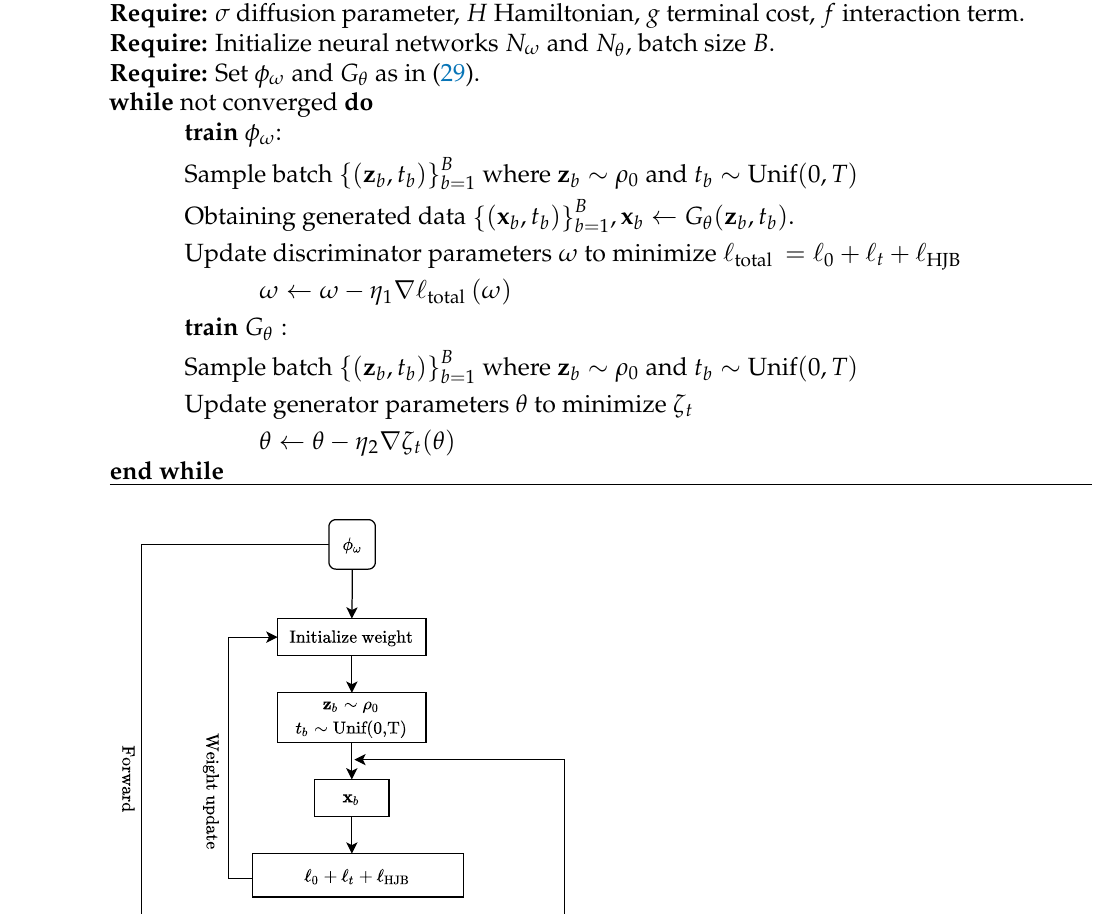
Algorithm 1 GAN-based algorithm for complex-scenario MFGs